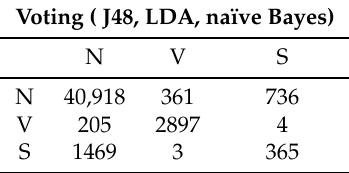
Table 18. Confusion matrix for combining J48, LDA, and naïve Bayes classifiers using a Voting scheme (N,S,V).